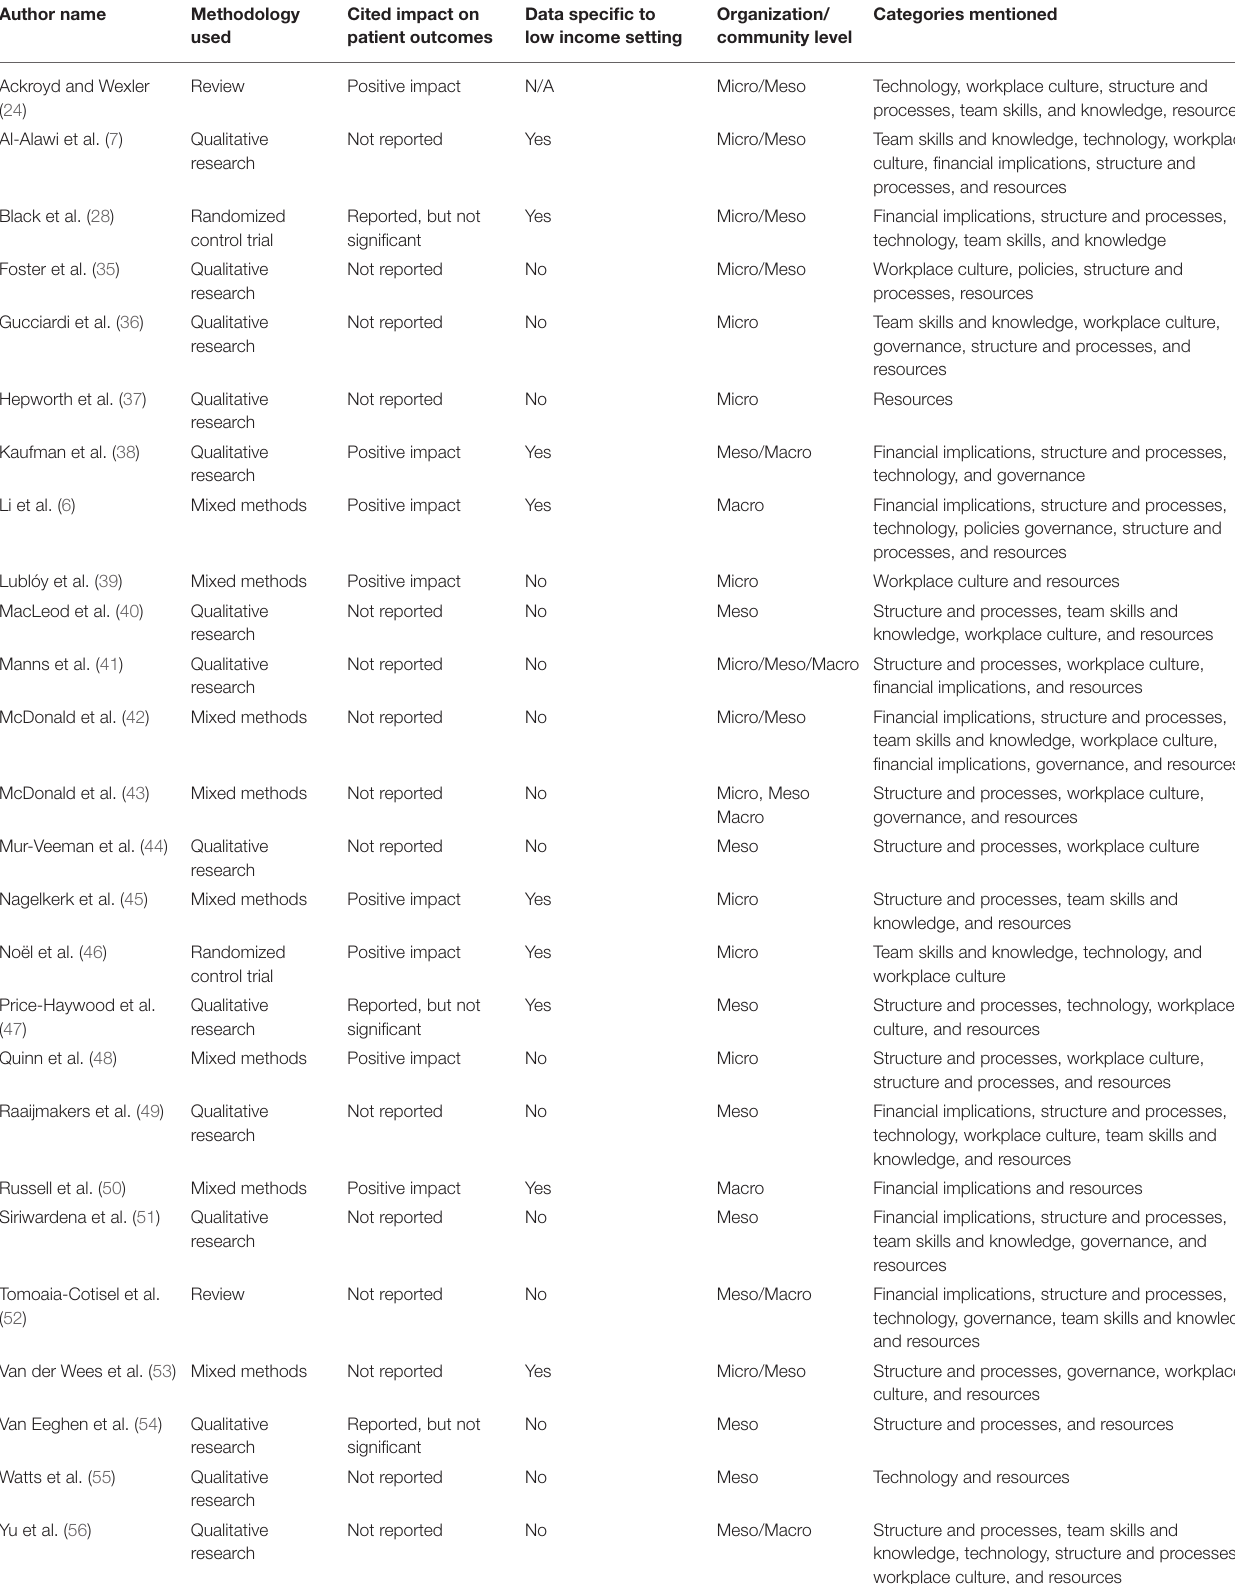
TABLE 1 | Summary of literature